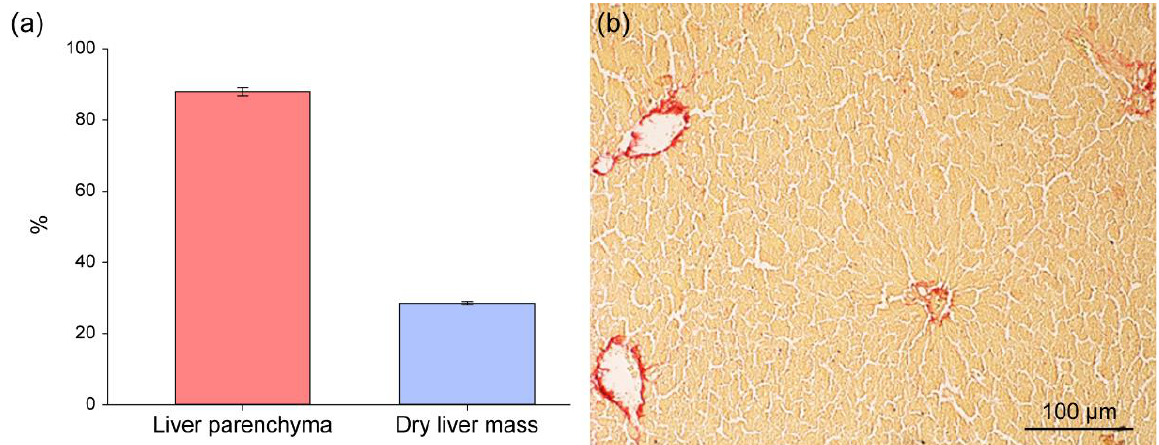
Figure 2. A percentage of the parenchyma and dry mass of rat liver ( a ). Rat liver section stained with picrosirius for morphometric analysis of liver parenchyma ( b ).